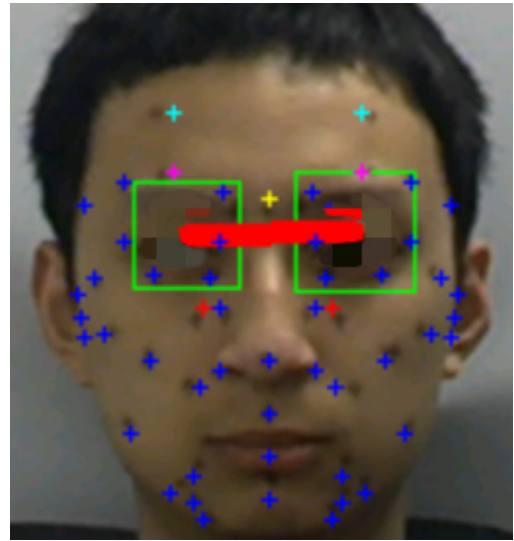
Figure 2: Virtual acupoint map on the view of frontal face in training mode.